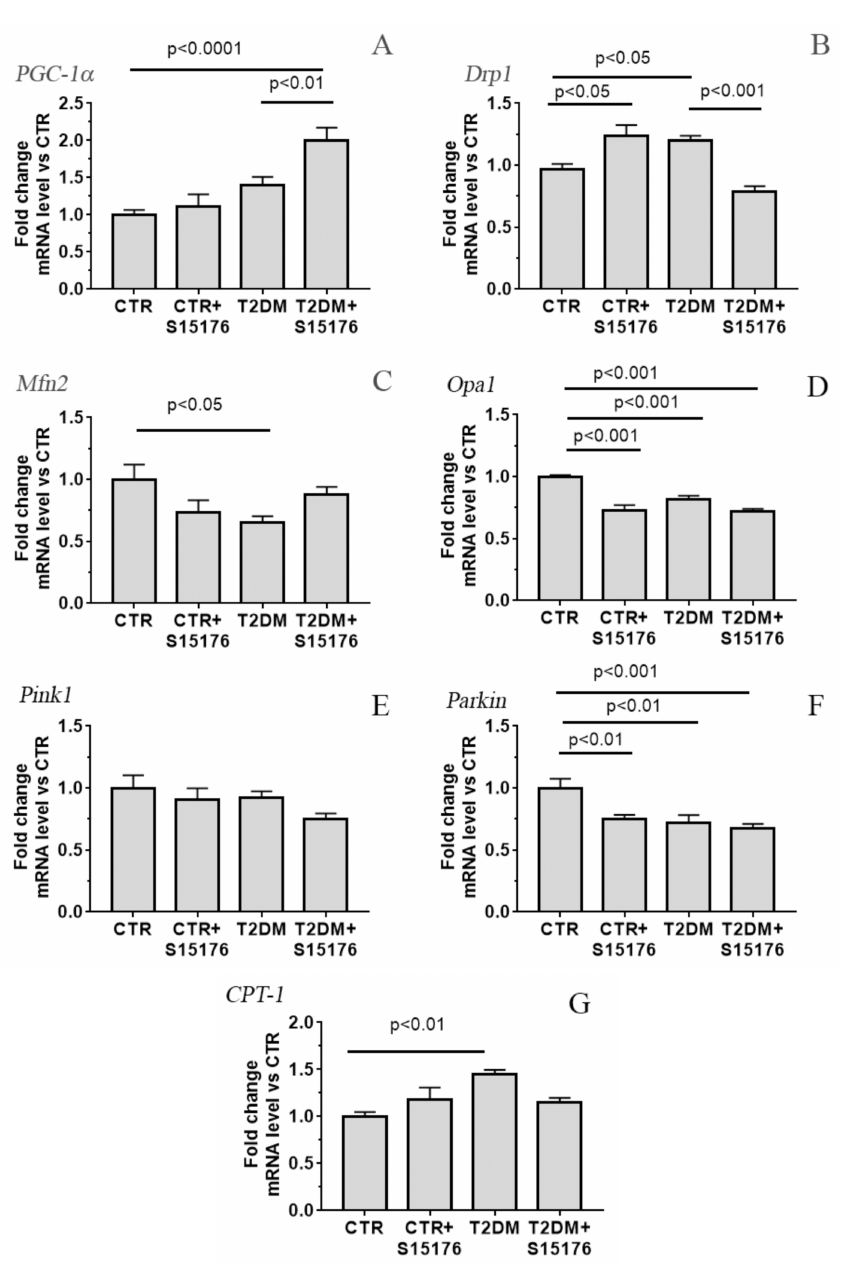
Figure 5. The mRNA levels of Ppargc1a ( A ) Drp1 ( B ), Mfn2 ( C ), Opa1 ( D ), Pink1 ( E ), Parkin ( F ), and Cpt1a ( G ) in the liver of experimental animals ( n = 5–6). The di ff erences were considered statistically significant at p <